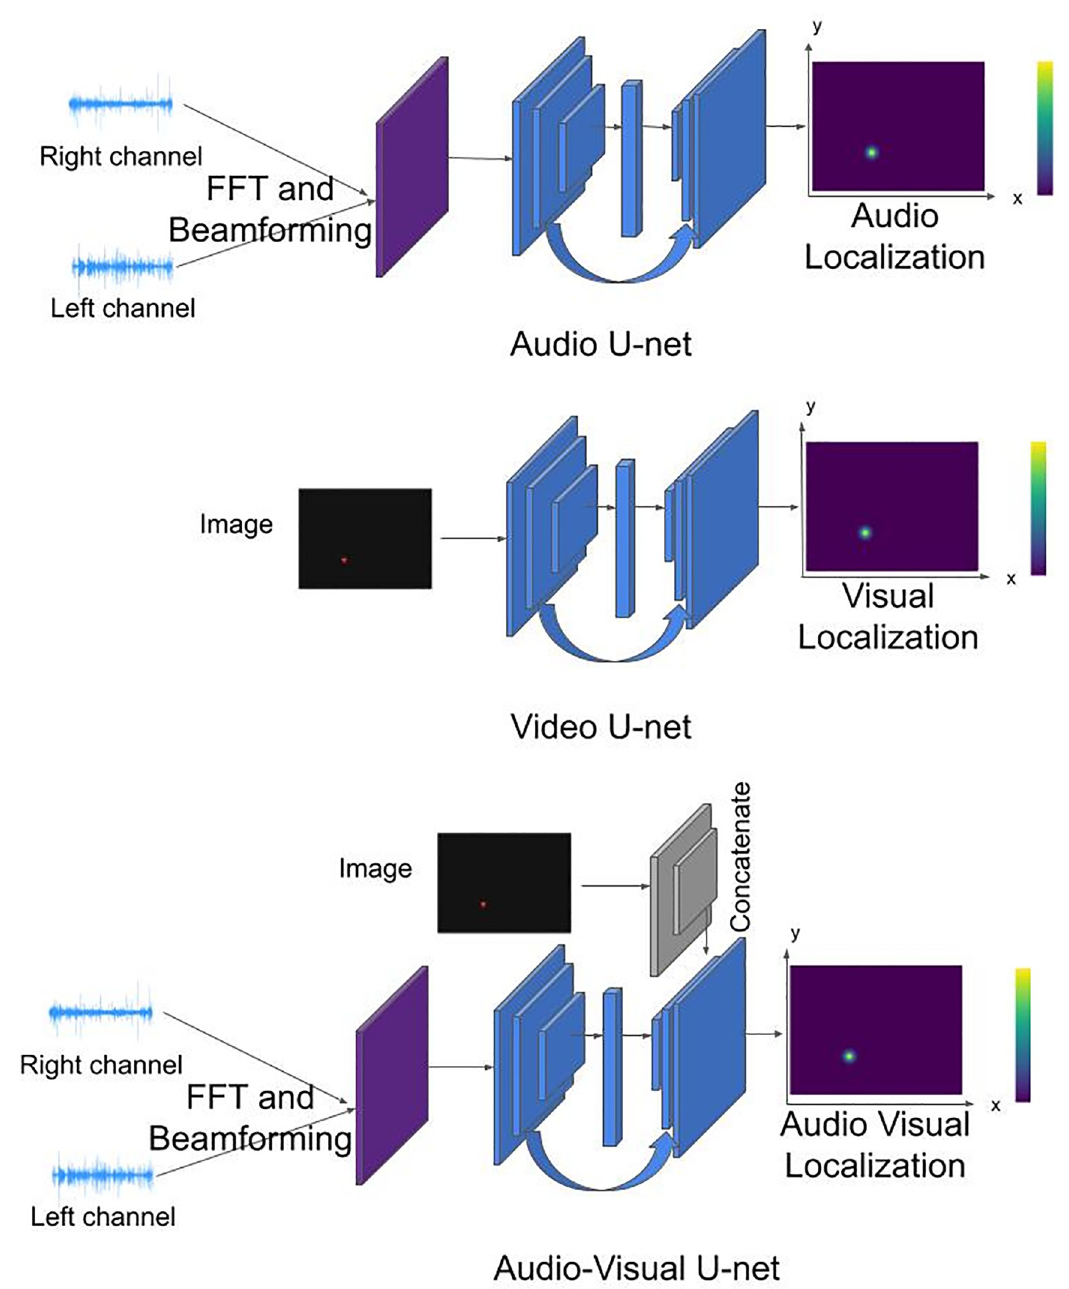
Fig 2. The considered models: Audio, video, and audio-visual U-net with the corresponding inputs: Audio features obtained from beamforming preprocessing, image of the LED in the dark room, or both. The networks are able to generate a 2D localization map of the visual stimulus in the case of Video U-net, or an audio impulse in the case of Audio and Audio-Visual U-net. https://doi.org/10.1371/journal.pone.0280987.g002 audiovisual localization experiments. For visual stimulation, we provided the model a 224x298x3 image replicating the LED stimuli (resizing it from the original 360x480 resolution to be suitable as network’s input, with the third dimension indicating the 3 RGB channels); as auditory stimuli, we fed a 500 ms audio trace collected with a sampling frequency of 12288 Hz